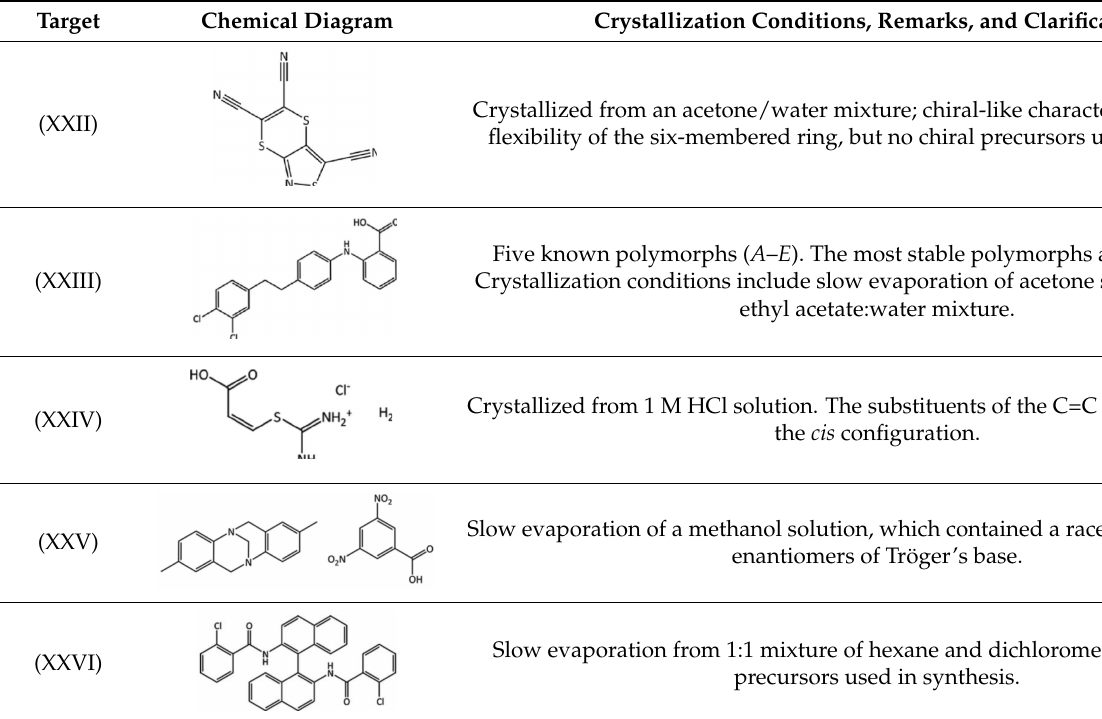
Table 2. The five systems used in the sixth blind